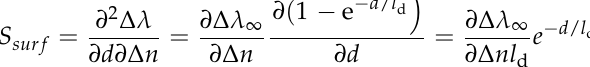
Table 1. Comparison of FOSPR sensing tips prepared by different processing techniques.